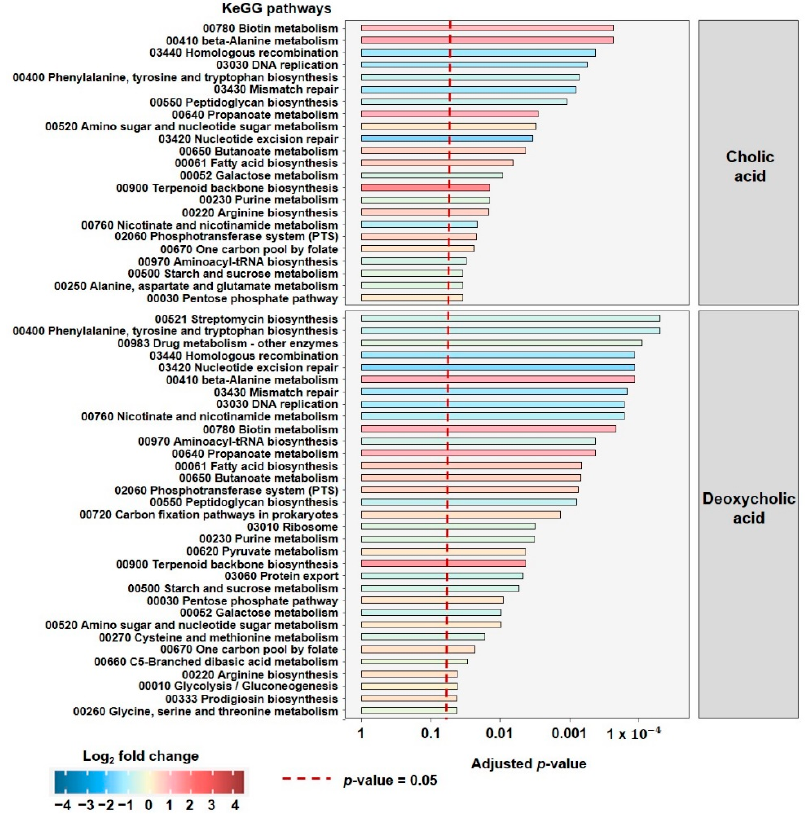
Figure 5. Molecular response of A. caccae towards CA and DCA in co-culture with E. lenta vs. single culture. Depicted are the significantly altered KEGG metabolic pathways based on the relative abundance of proteins detected. The proteins stem from the bacterial pellet harvested form the end of the bile acid stress assays. The direction of the change is color-coded, red indicates an increase, blue a decrease in the fold change in the co-culture.